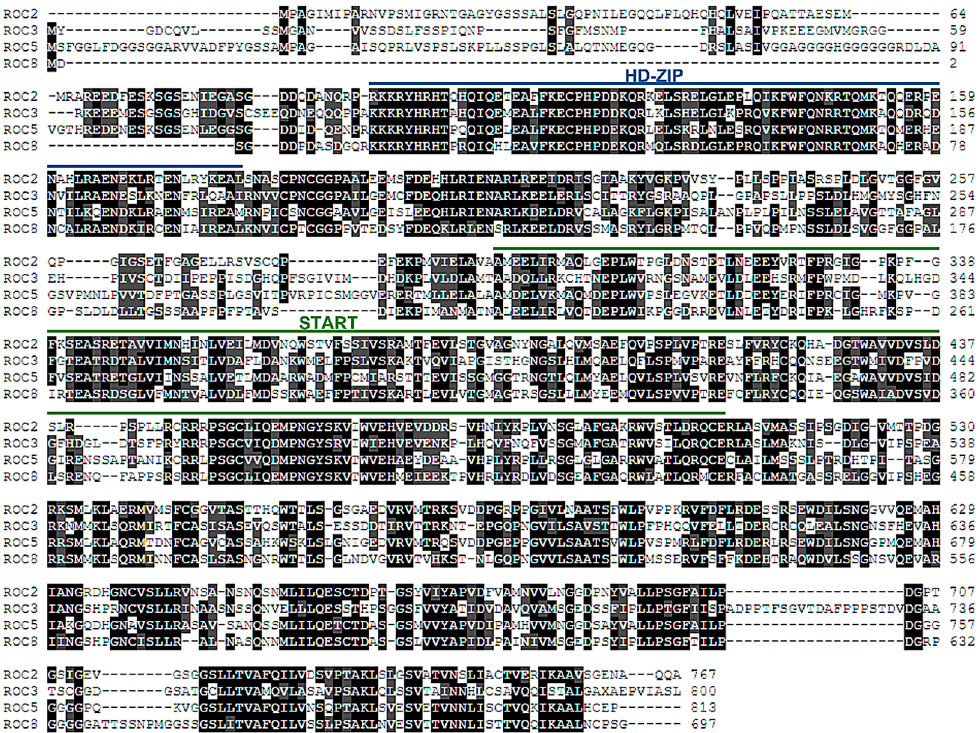
Figure 4. Protein sequence analysis of the oil palm EgHD-ZIP IV family. Multiple protein sequence alignment was performed using the Clustal Omega, and colored alignment with 70% identity was performed using Colour Align Conservation. Identical amino acids were colored in black, and similar amino acids were colored in gray. Blue and green bars indicated HD-ZIP and START domains, respectively.